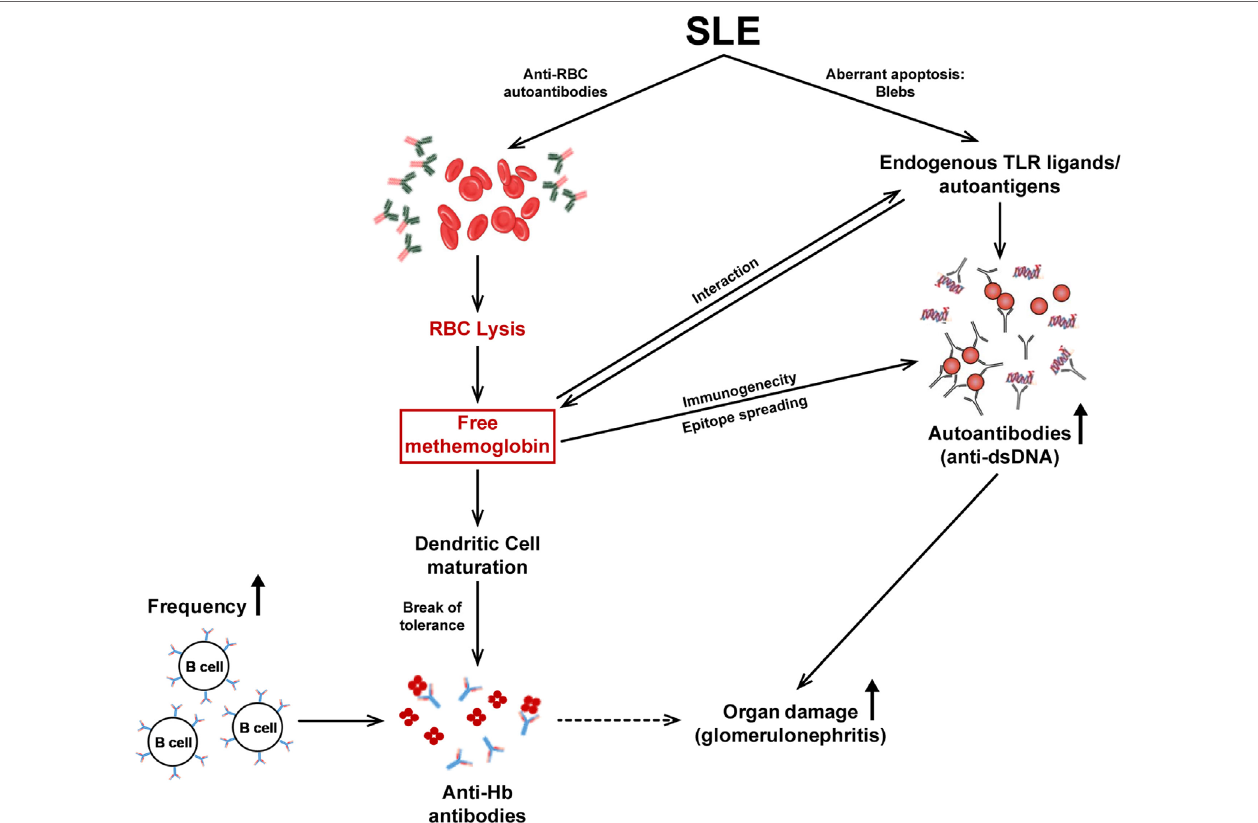
FigUre 8 | The immunobiology of Hb in systemic autoimmune disease. Autoimmune hemolysis leads to the release of Hb. If the haptoglobin-mediated clearance mechanism is overwhelmed, free Hb readily oxidizes to methemoglobin (Fe 3 + Hb). Fe 3 + Hb interacts with endogenous toll-like receptor (TLR) ligands/autoantigens and DAMP molecules present in apoptotic blebs, present at high concentrations in lupus. Hb and autoantigens, independently or as complexes, affect the functional maturation of antigen-presenting cells and subsequent cytokine secretion. Mature DCs present antigens to T cells leading to their activation; the ensuing cytokine secretion assists in the generation of autoantibodies by B cells. In addition, the higher Hb-specific B cell precursor frequencies in autoimmune-prone mice, as well as the binding of Hb to conventional endogenous TLR ligands/autoantigens (against which activated T cells already exist) may contribute to the break in B cell tolerance to Hb that ensues; consequently, isotype-switched anti-Hb antibodies arise in the blood. The immunogenicity of Hb is revealed (upon active immunization) to be associated with epitope spreading, possibly resulting from converse assistance to B cells specific for conventional autoantigens as a consequence of Hb–autoantigen complexation; heightened autoimmune reactivity against proteinacious, nucleic, and lipidic autoantigens results. The increased presence of autoantibodies to Hb and dsDNA (as well as to other moieties) in the kidneys correlates with the deposition of complement and with severe